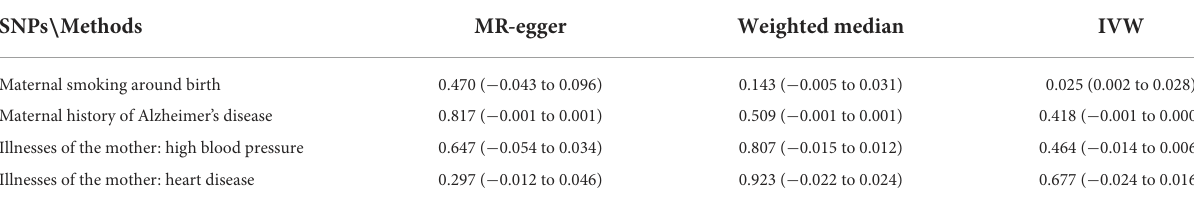
TABLE 3 Causal effects of four types of maternal smoking around birth and maternal diseases on childhood asthma based on two-sample Mendelian randomization. SNPs \ Methods